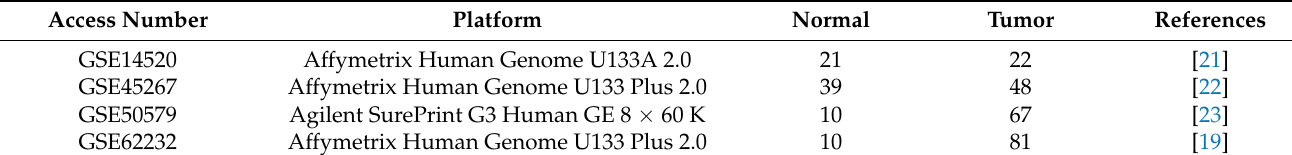
Table 1. Microarray data sets for hepatocellular carcinoma patients.